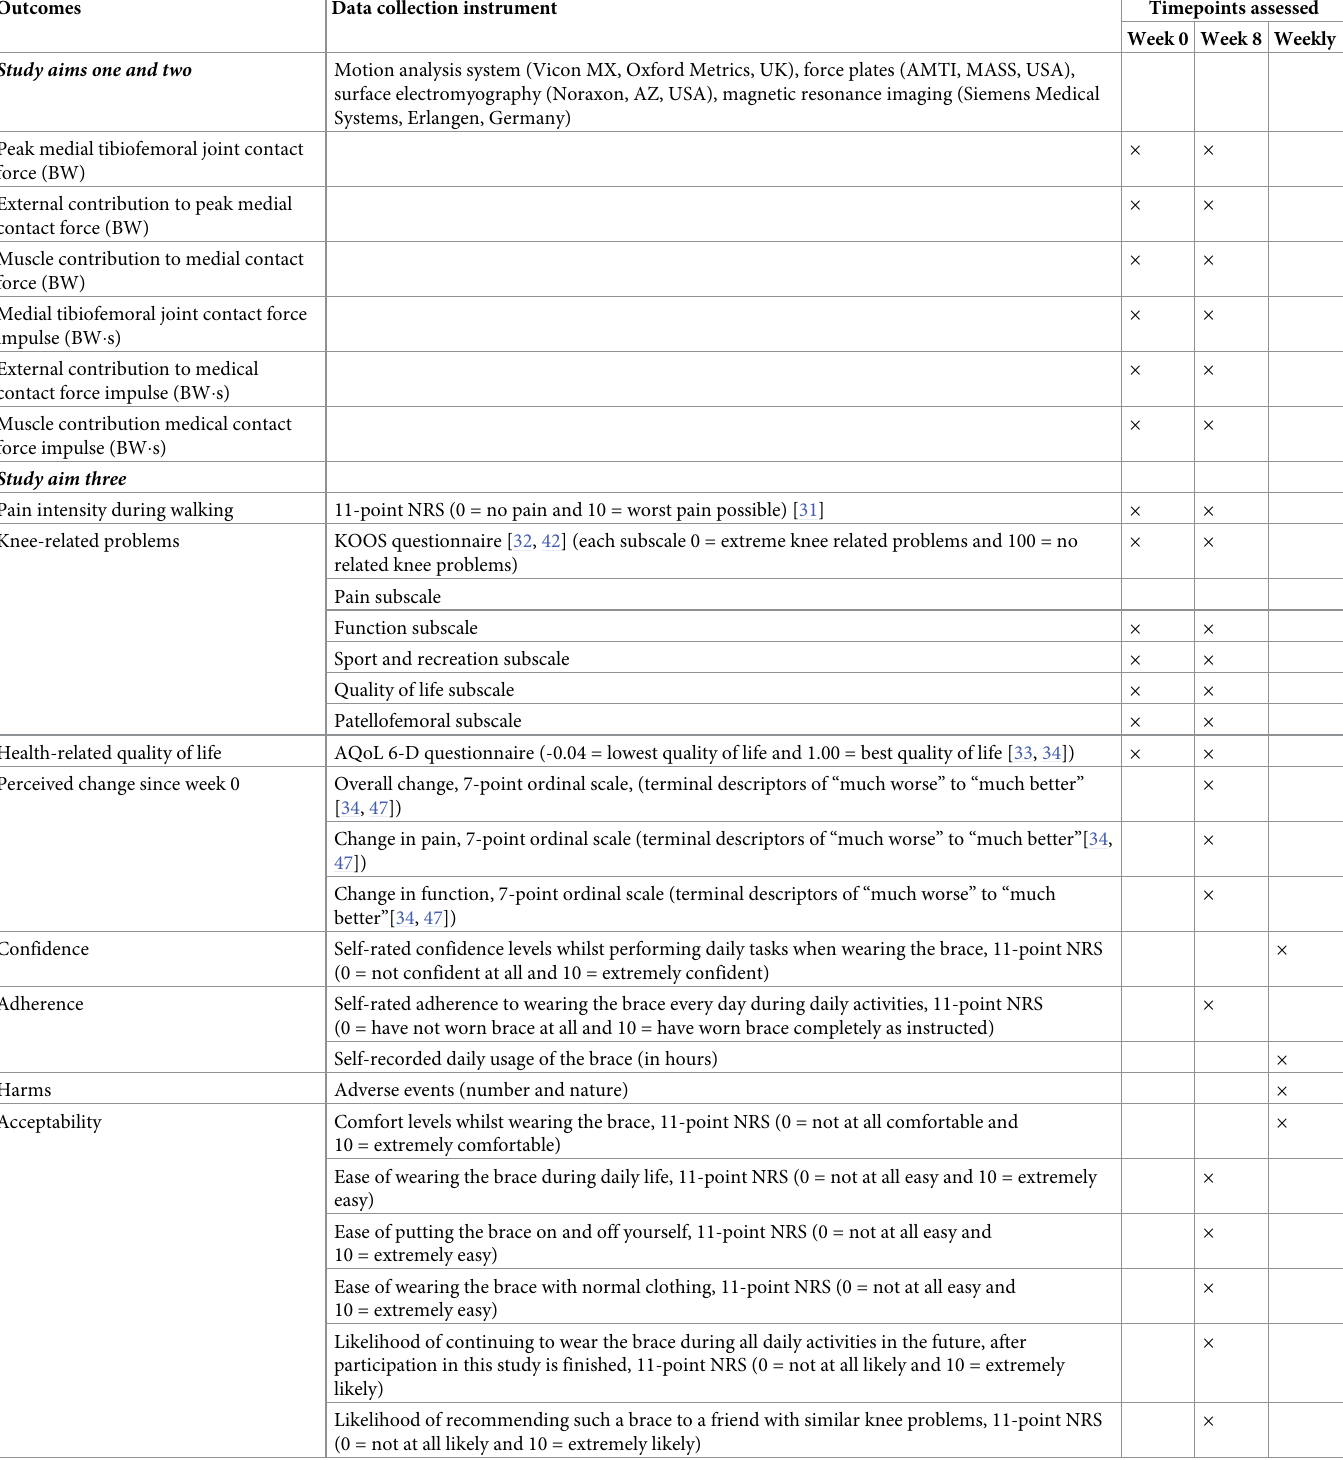
Table 1. Outcomes.